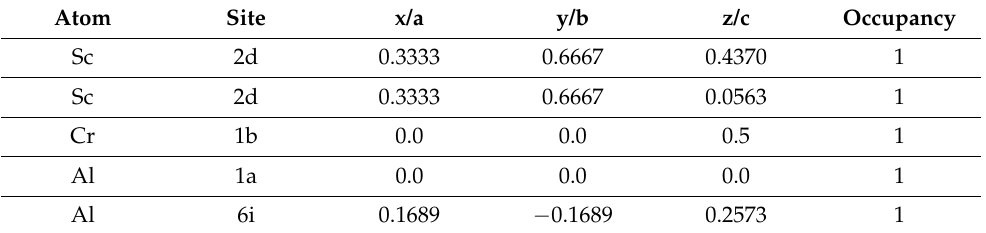
Table 6. Atomic coordinates of the relaxed Al 52.08 Cr 14.58 Sc 33.33 . Atom Site